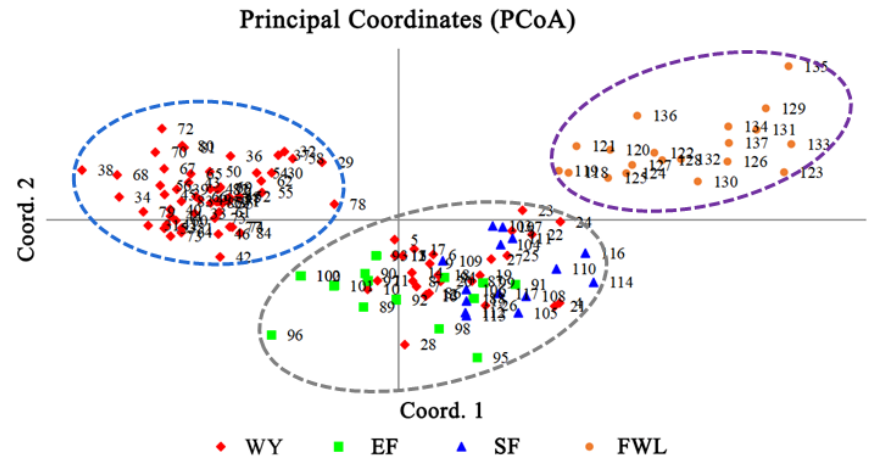
Figure 3. PCoA plot of 137 samples based on the top three principal components with different colors representing the